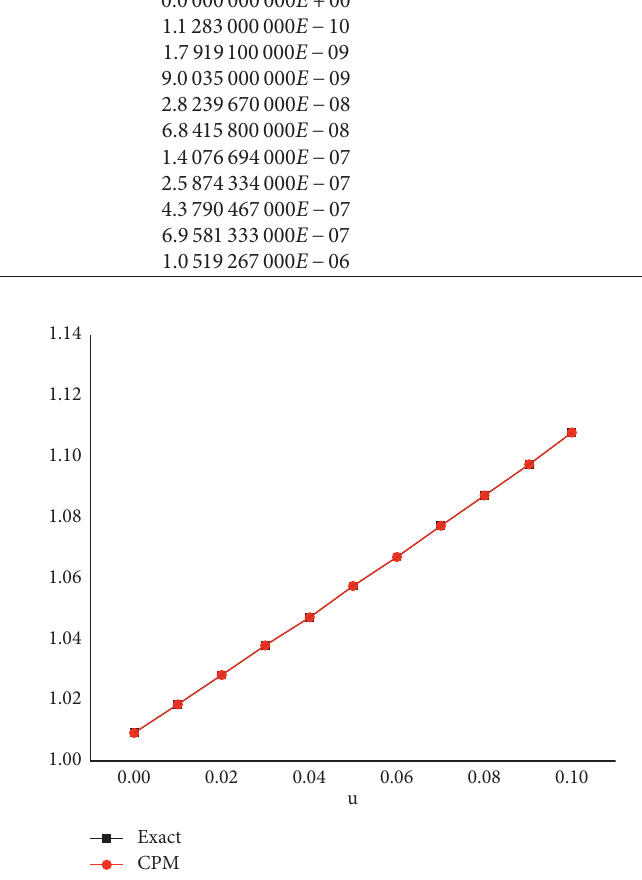
Figure 1: The exact and CPM solution graph for problem